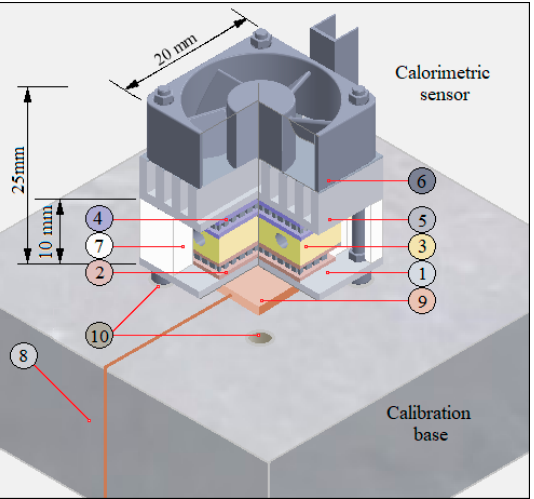
Figure 1. Diagram of the sensor in its calibration base. (1) aluminium plate, (2) measuring thermopile, (3) thermostat, (4) cooling thermopile, (5) aluminium heatsink, (6) fan, (7) thermal insulation, (8) calibration base (insulating material), (9) copper plate containing the calibration resistance, (10) magnets to hold the sensor in the base.